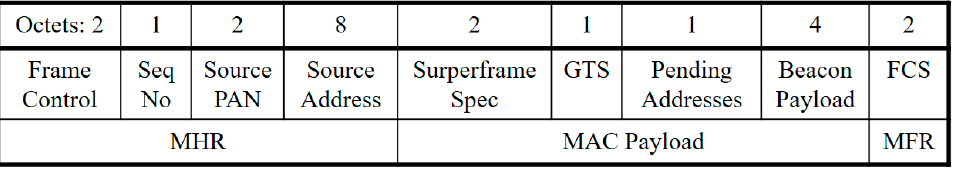
Figure 2. Format of signal frame in trace experiments.